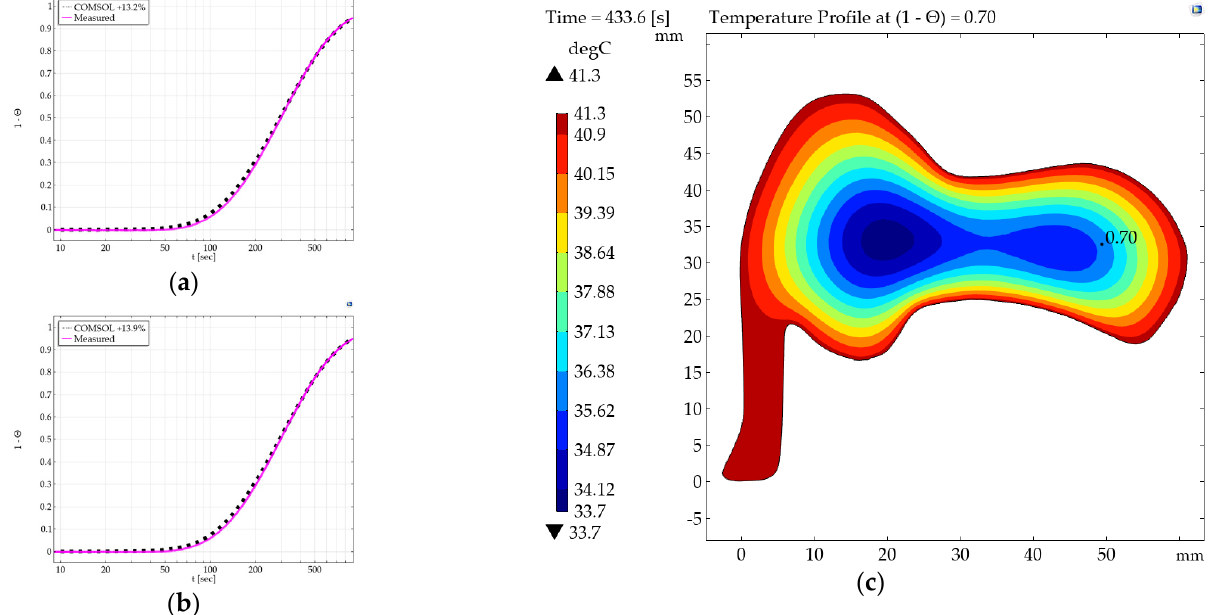
Figure 10. Two (E1_#4 ( a ), E1_#5 ( b )) measurement results of elephant plotted against fitted 3D simulation output for thermal diffusivity and a lengthwise cross section of E1_#4 ( c ) [12].